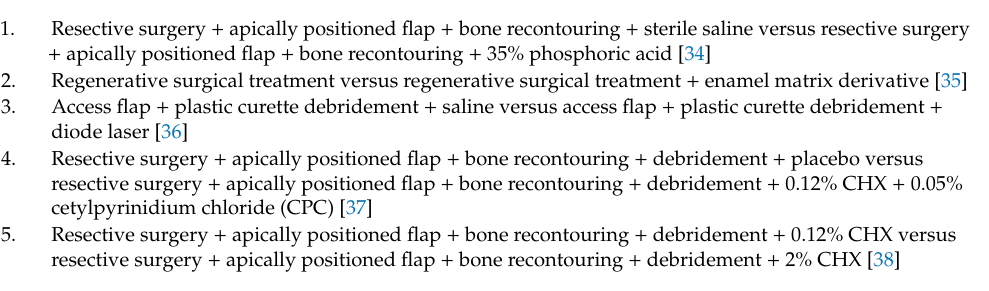
Table 5. Surgical treatment